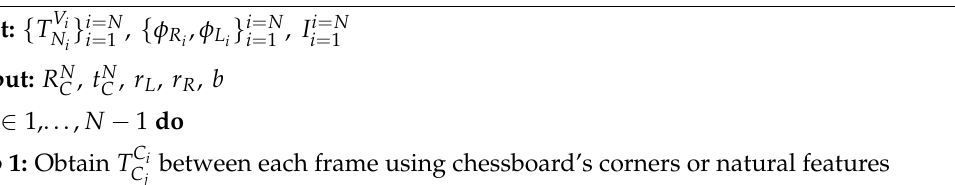
Algorithm 1 Full algorithm simultaneous calibration for mobile robot with pan-tilt